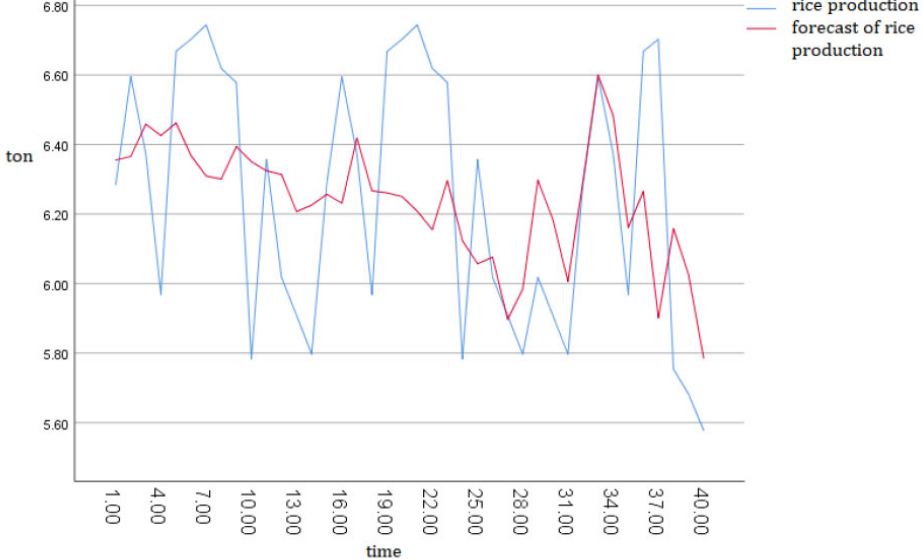
Figure 1. Trends in rice productivity in West Java area.